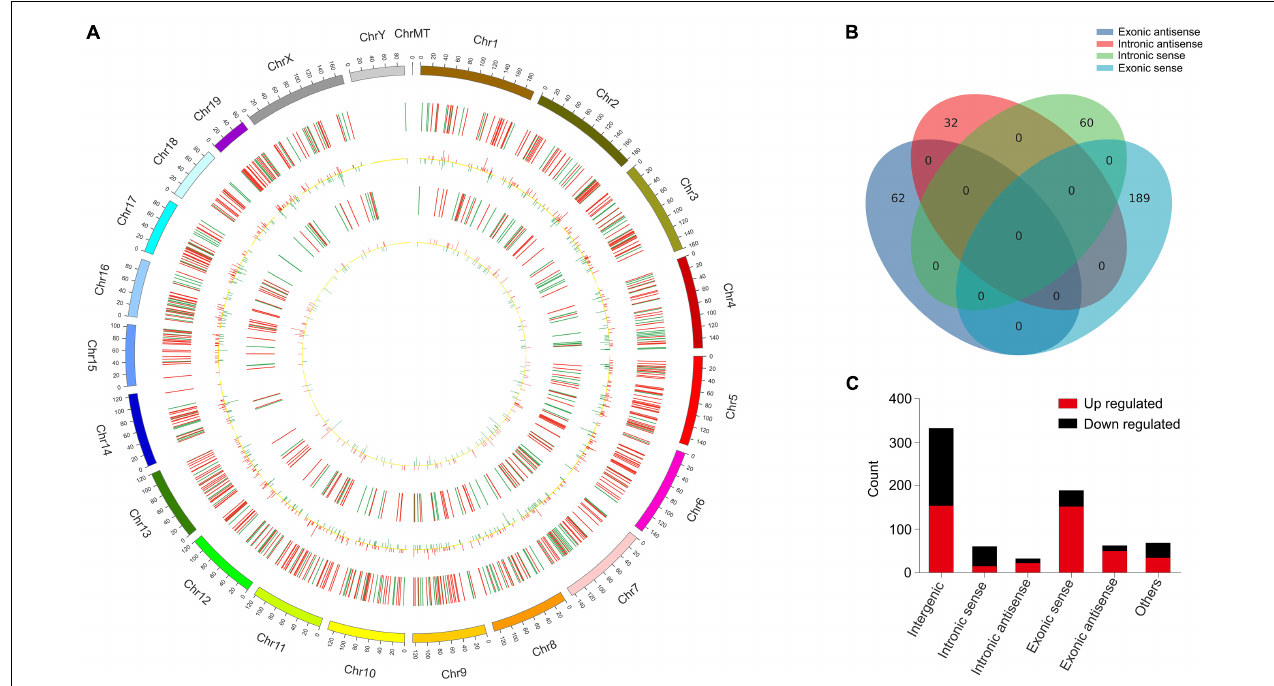
FIGURE 3 | Identification of differentially expressed long non-coding RNAs (lncRNAs) in OVX. (A) Circos plot showing lncRNAs and mRNAs on mouse chromosomes. From the outside in, the first layer of the Circos plot is a chromosome map of the mouse genome. The second layer represent the distribution of DElncRNA in mouse chromosomes. Red indicates increased expression, and blue denotes decreased expression. The third layer represent the mean expression values of significantly differentially changed lncRNAs in OVX. The fourth circle represent the distribution of DEmRNA in mouse chromosomes. The fifth layer represent the mean expression values of significantly differentially changed mRNAs in OVX. Red indicates increased expression, and blue denotes decreased expression. (B) Venn diagram presents overlapping relationships, and the numbers indicate lncRNA counts. (C) Types and counts of differently regulated lncRNAs classified into six categories according to the genomic loci of their neighboring